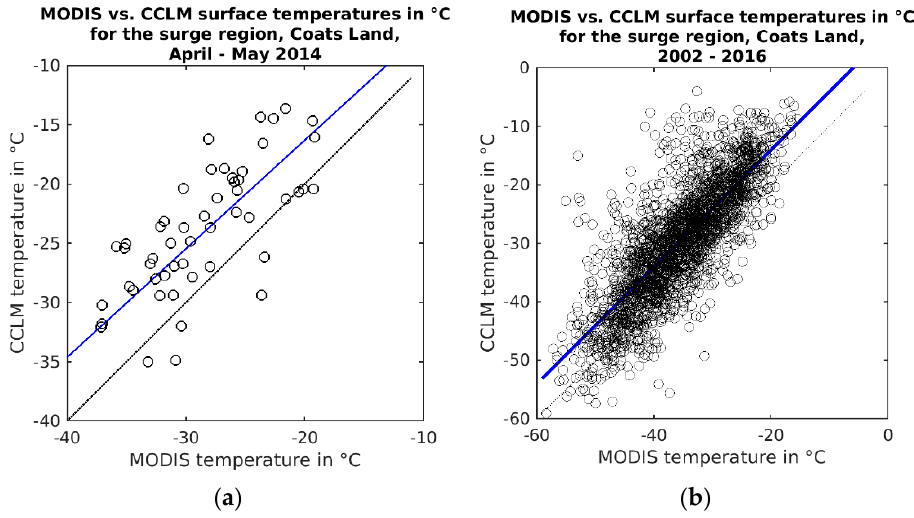
Figure 14. IST from MODIS and CCLM for the surge area for April and May 2014 ( a ) and for winters 2002–2016 ( b ). The blue line indicates the linear fit.